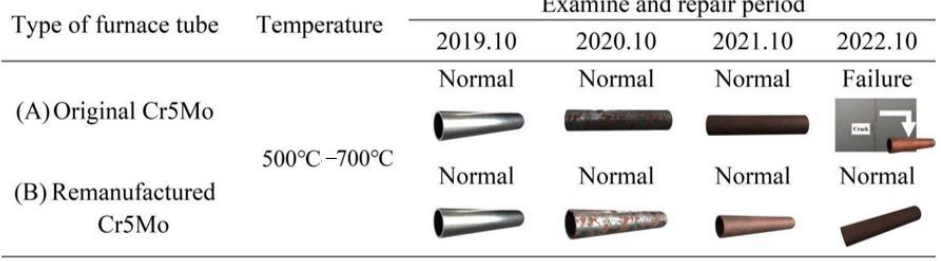
Figure 18. Overhaul period of the ( A ) original and ( B ) remanufactured Cr5Mo furnace tube in a certain petrochemical enterprise.